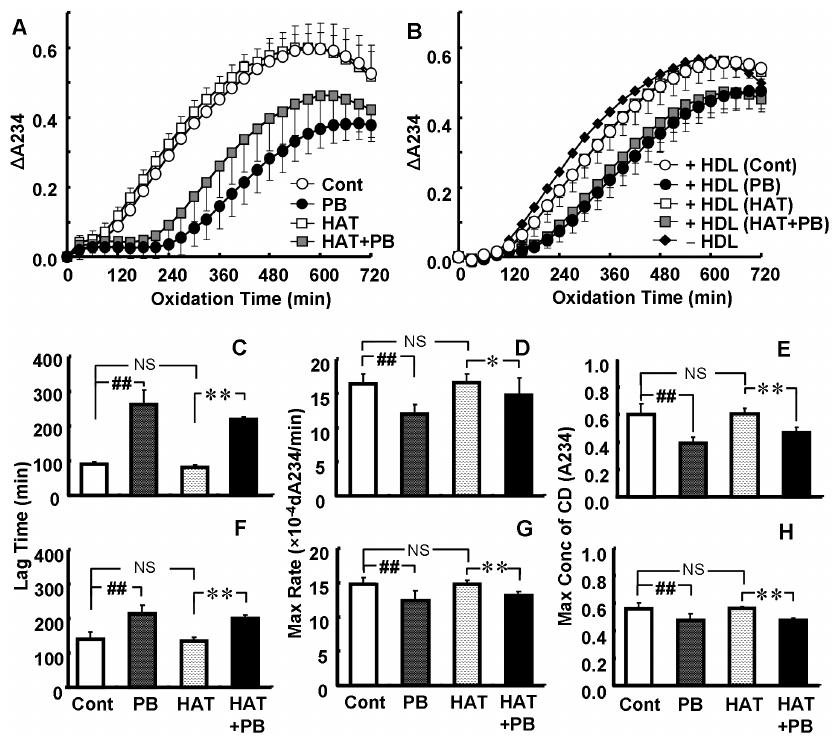
Figure 5. Protective Effects of probucol on LDL-oxidation. Effects on LDL-oxidation (A, C, D, E) and anti-oxidative effects of HDL on LDL- oxidation (B, F, G, H). LDL was oxidized by AAPH. Pooled LDL from the control group was used as reference LDL in the experiment examining the anti- oxidative effects of HDL. Data are presented as mean 6 SD. There were 11 animals in the control (Cont) and 0.1% probucol (PB) groups, and 12 in the 0.003% atorvastatin (HAT) and HAT + PB groups. The lines of HDL (HAT) and HDL (HAT + PB) are overlaid by HDL (Cont) and HDL (PB), respectively (B). *p , 0.05; **p , 0.01 by unpaired t-test. ## p , 0.01; NS, not significant by Dunnett’s test. Max Rate, maximum rate of oxidation; Max Conc of CD, maximum concentration of conjugated